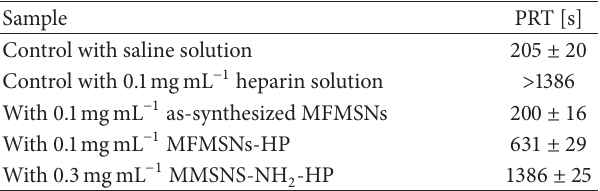
Table 2: Comparison of PRT obtained in the absence and presence of MFMSNs-HP. Sample PRT [s] Control with saline solution 205 ± 20 Control with 0.1mg mL −1 heparin